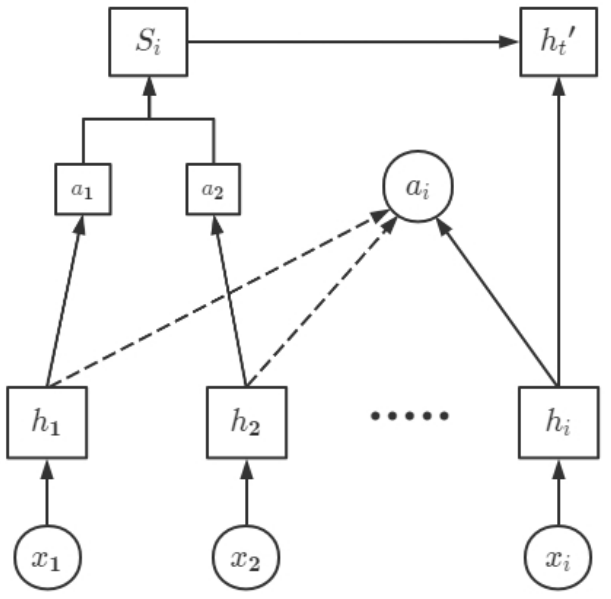
Figure 9. Attention mechanism